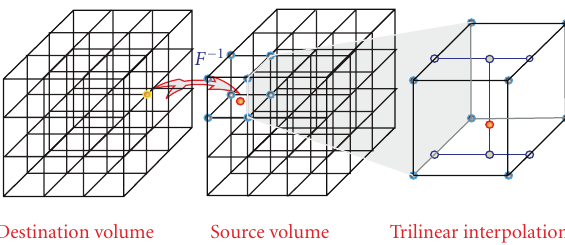
Figure 7: Reverse mapping based on 3D trilinear interpolation that eliminates the missing data of a forward mapping. The implementation on GPU exploits the hardware interpolation engine to achieve significant speedup.